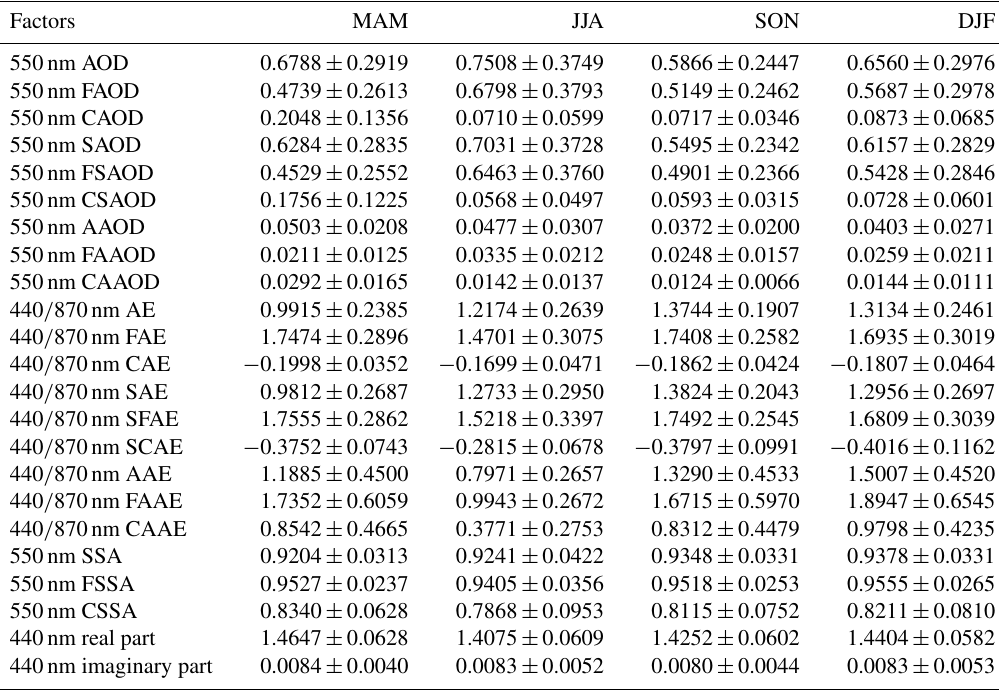
Table 2. Seasonal mean ± SD of the columnar aerosol optical properties in the urban area of Nanjing.